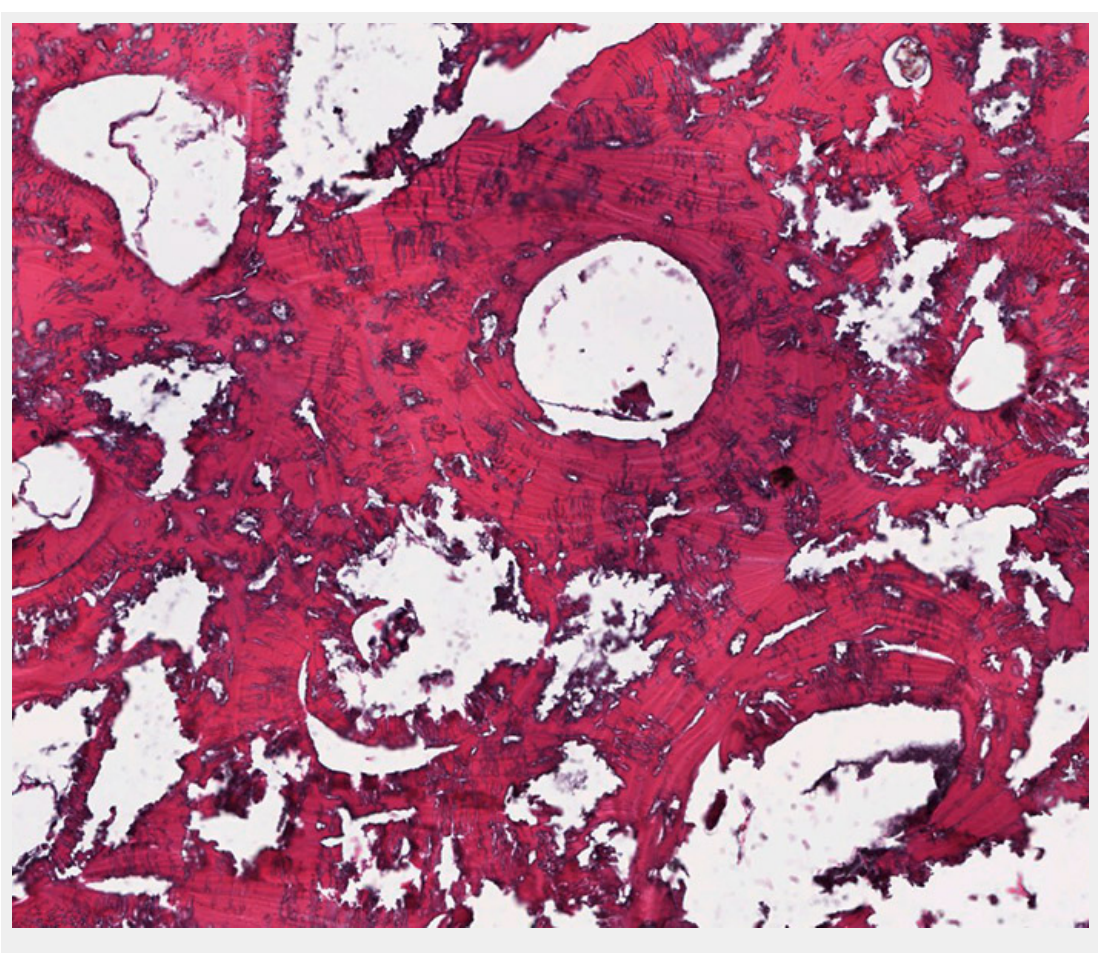
Figure 9 Paraffin embedding, haematoxylin and eosin, 40x. Sample taken out of the